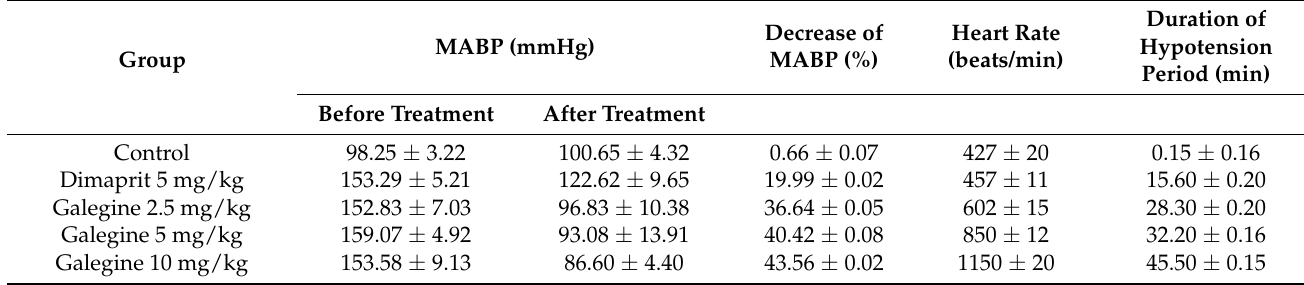
Table 3. Effect of galegine on mean arterial blood pressure (MABP) of pentobarbital-anesthetized hypertensive